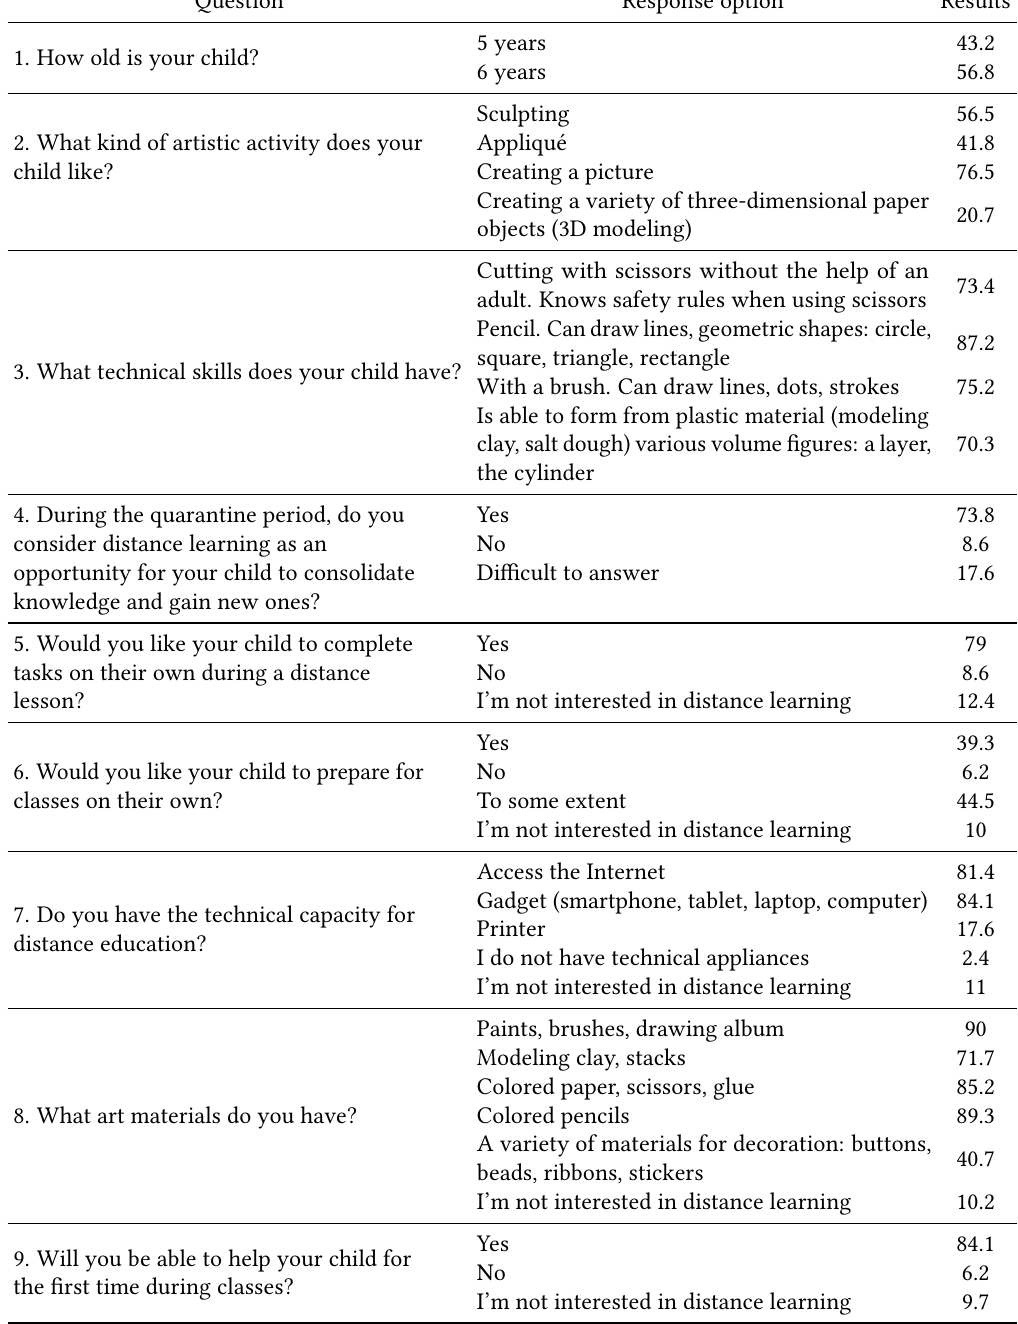
Table 2 Parents survey